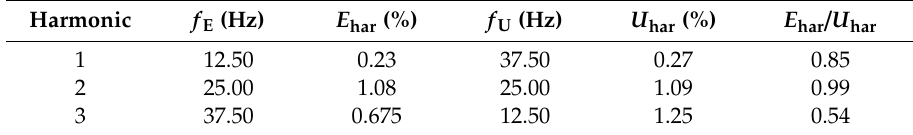
Table 1. Harmonic component of illuminance and supply voltage at the beginning of the working cycle.